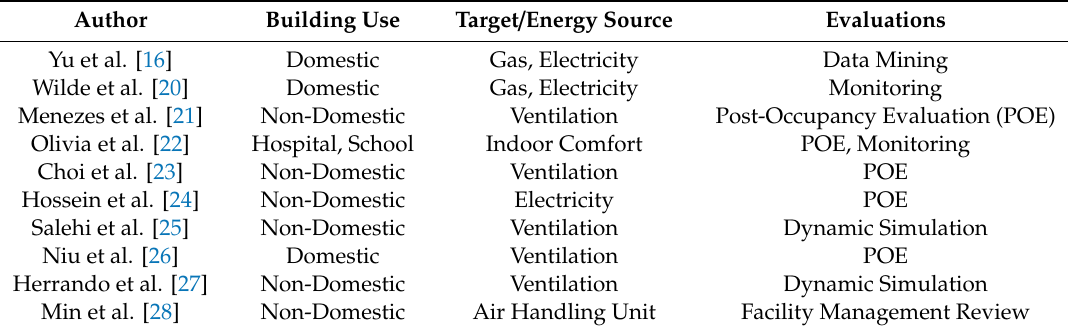
Table 1. Published papers on the building energy